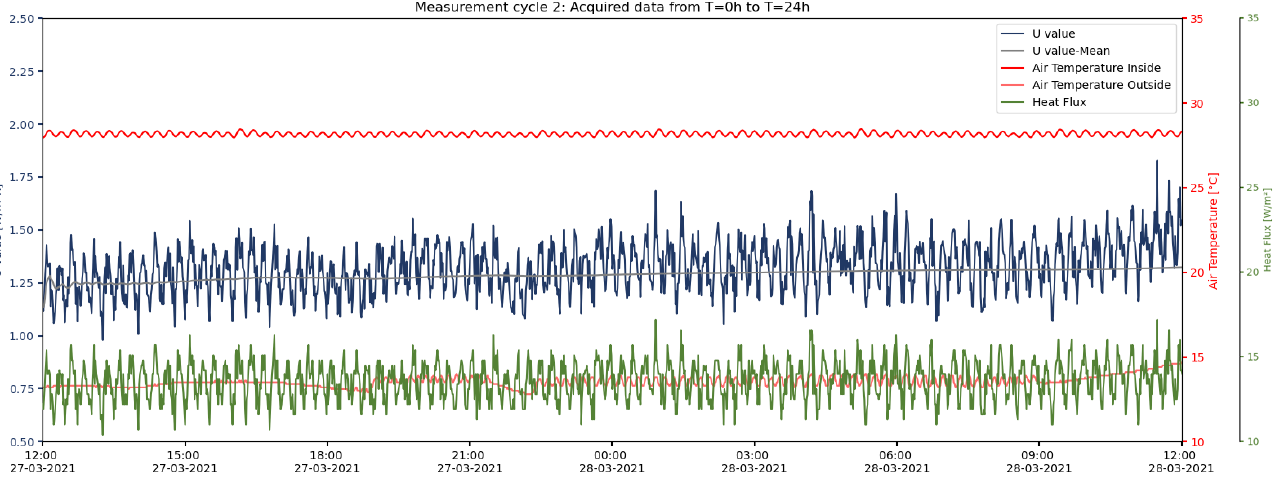
Figure 8. Results of the heat flux measurement cycle 2 from T = 0 h to T = 24 h.